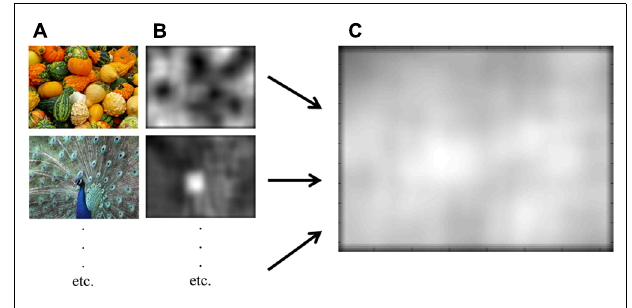
FIGURE 2 |Visual saliency analysis. (A) Two example images of the functional visual field test (courtesy of Gabriele Schoenemann, Kurt Bouda/pixelio.de). (B) Corresponding saliency maps. (C) Mean saliency map over all 30 images.